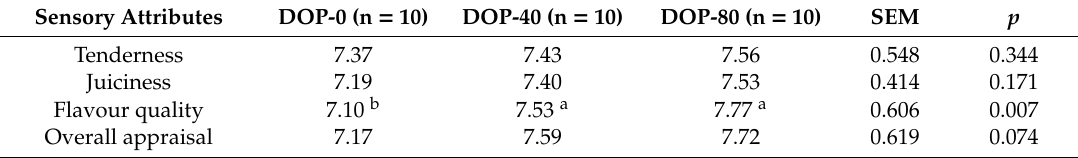
Table 6. Evaluations of the tenderness, juiciness, flavour quality, and overall quality of the meat of suckling goat kids by untrained panellists, according to the use of dehydrated orange pulp in feeding dams 1 . Sensory Attributes DOP-0 (n = 10) DOP-40 (n = 10) DOP-80 (n = 10) SEM p Tenderness 7.37 7.43 7.56 0.548 0.344 Juiciness 7.19 7.40 7.53 0.414 0.171 Flavour quality 7.10 b 7.53 a 7.77 a Overall